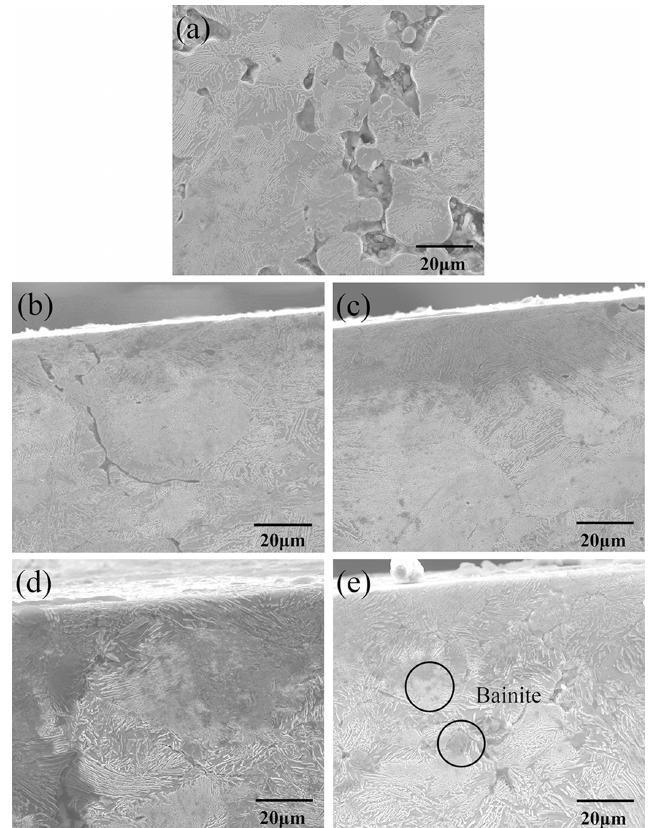
Figure 3. Microstructure images of different samples ( a ) unrolled ( b ) cold-rolled; ( c ) rolled with a pre-heated heating temperature of 100 ◦ C; ( d ) rolled with a pre-heated heating temperature of 200 ◦ C; ( e ) rolled with a pre-heated heating temperature of 300 ◦ C.